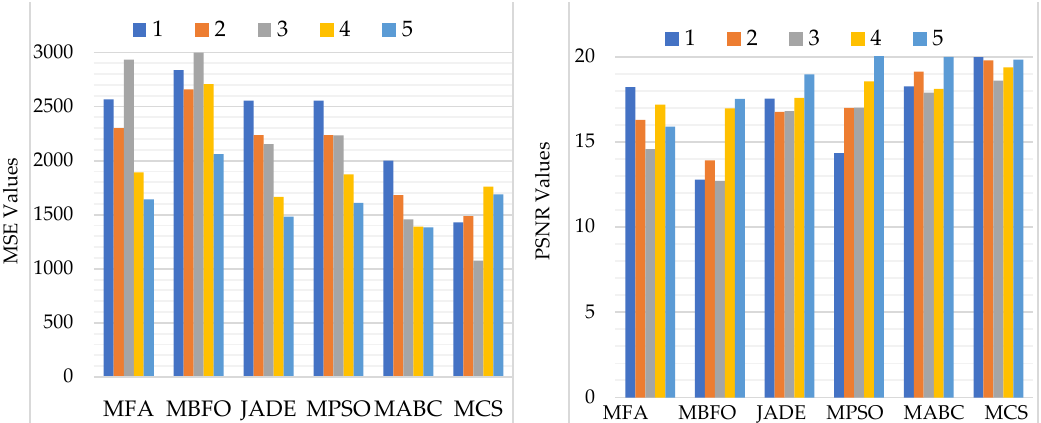
Figure 3. MSE and PSNR using different optimization algorithms with EC-Otsu. Table 3. MSE and PSNR values computed using different optimization algorithms with the EC-Otsu method.